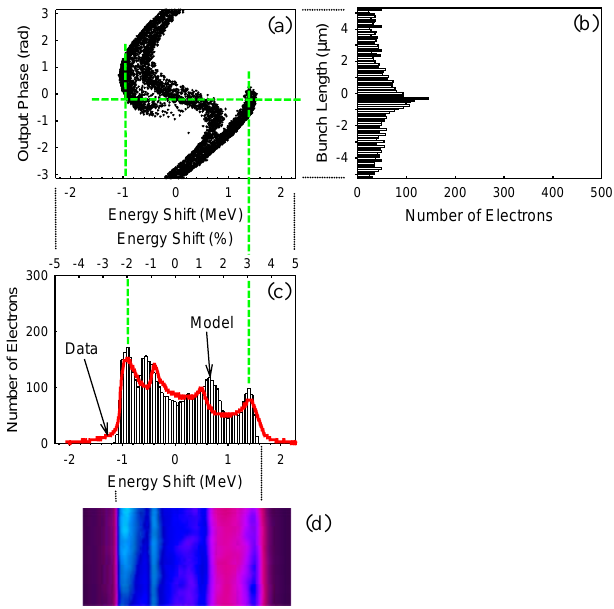
FIG. 8. (Color) Example of overmodulation in the buncher for phase delay 180 ± from Fig. 7. (a) Model-predicted electron out- put phase versus electron energy, (b) model-predicted electron bunch length, (c) electron energy spectrum, and (d) raw spec- trometer output for data plotted in